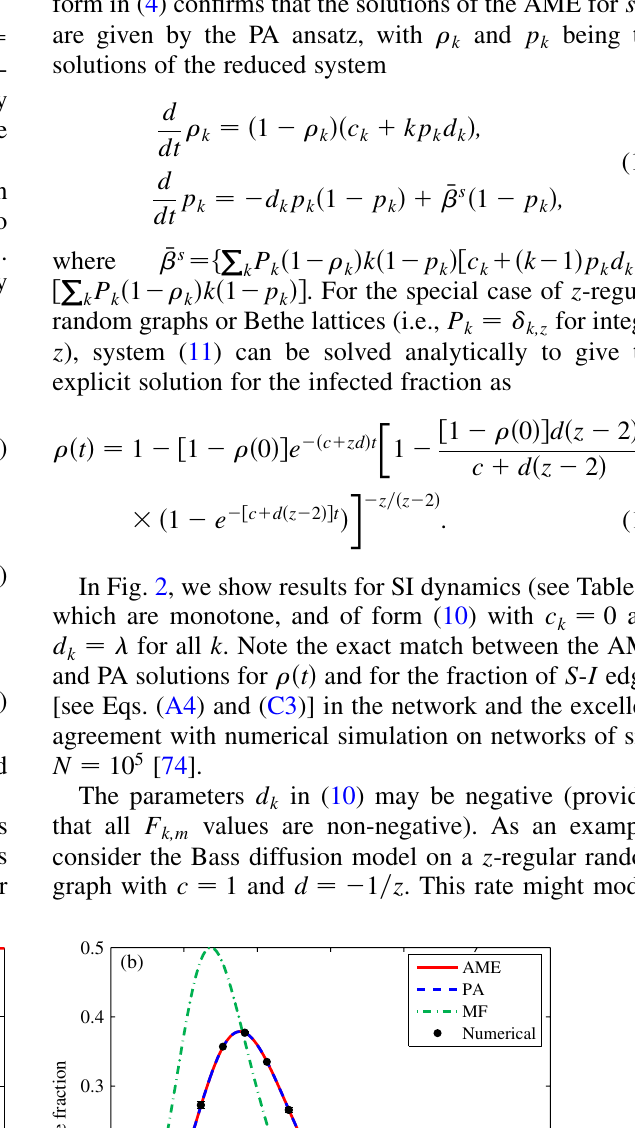
FIG. 2. SI dynamics (with transmission rate (cid:1) ¼ 1 ) on a truncated scale-free network, with degree distribution given by P ¼ 0 otherwise. The initial infected fraction is (cid:5) ð 0 Þ ¼ 10 (cid:1) 2 . Here, and in all for degrees in the range 3 (cid:4) k (cid:4) 20 and with P k subsequent figures, the symbols show the results of numerical simulations on networks of size N ¼ 10 5 , using the time step dt ¼ 10 (cid:1) 4 . The results are averages over 24 realizations; the error bars indicate the mean (cid:8) 1 standard deviation (but note that the error bars are smaller than the symbols in this